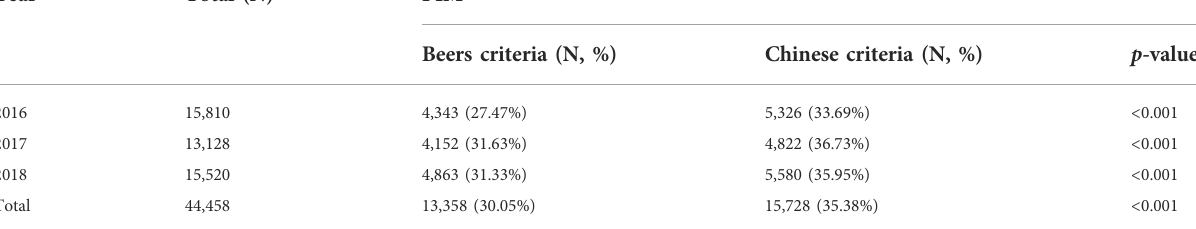
TABLE 2 Prevalence of PIMs based on the two criteria.